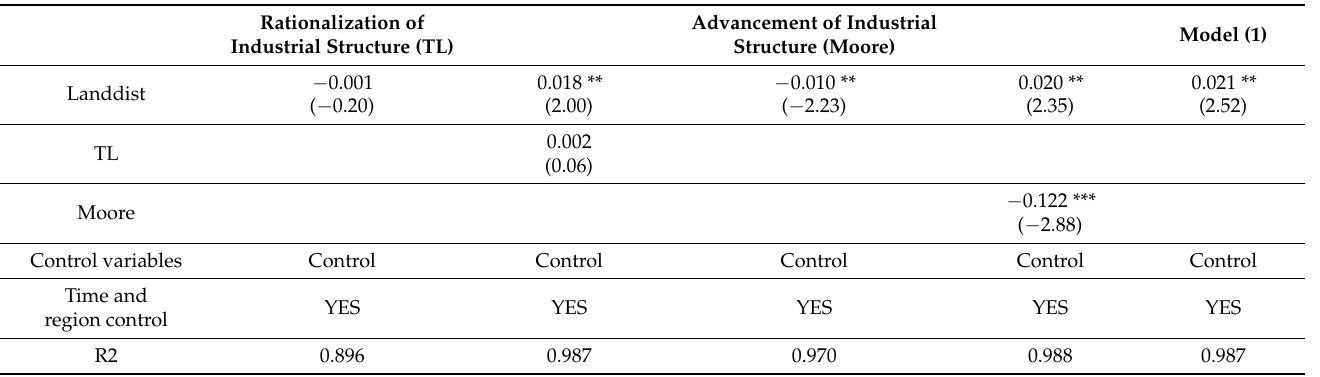
Table 7. An intermediate mechanism test of the effect of distortion in the price of industrial land concessions on carbon emission